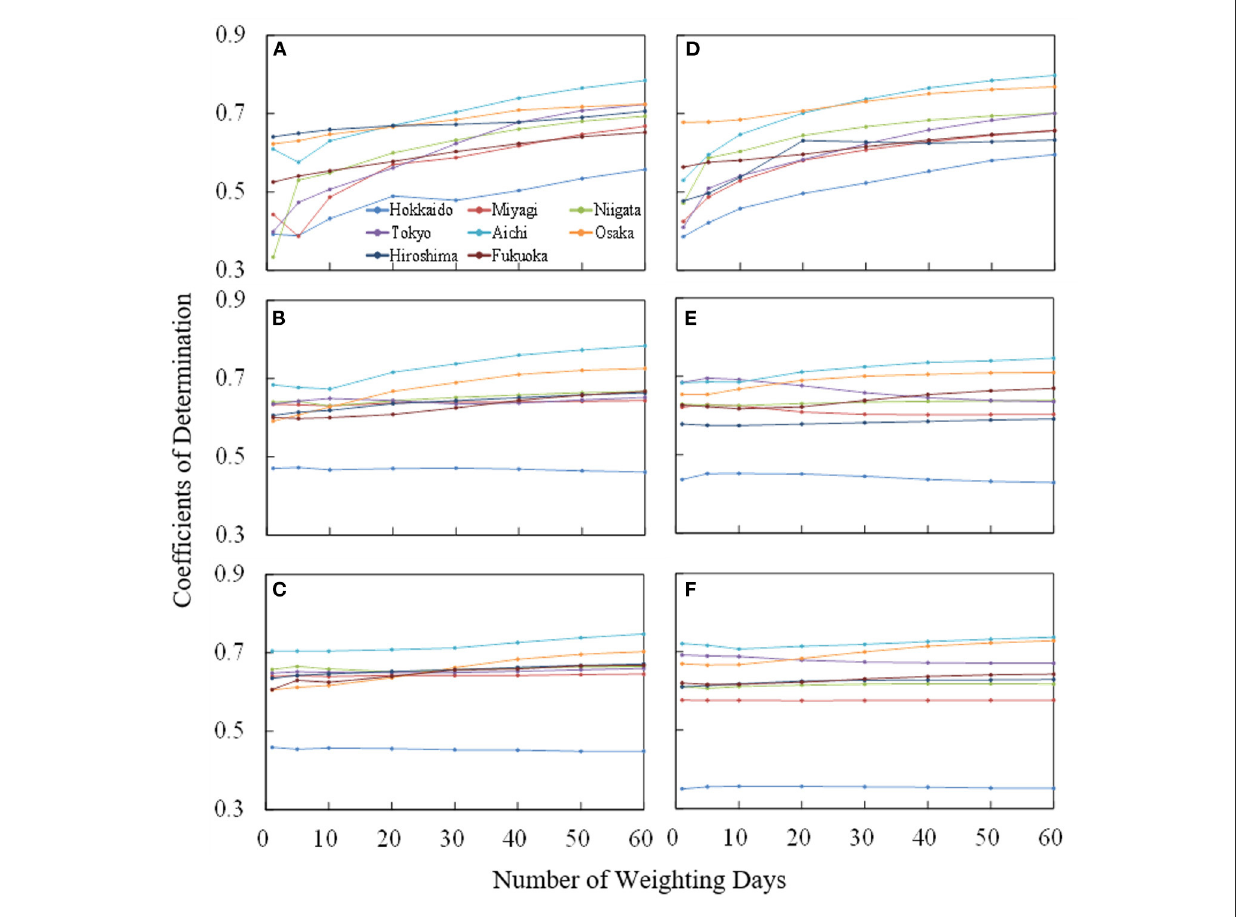
FIGURE3 Variation of coefficient of determination averaged over 7 years (from June 1 to September 30 from 2013 to 2019) for the number of days over which an input variable is averaged, corresponding to J in Equation (4). For the number of patients transported the indoor locations, the (A) ambient temperature, (B) amount of sweating, and (C) body core temperature increase were considered. The same evaluation was conducted for patients transported from outdoor locations in (D–F)